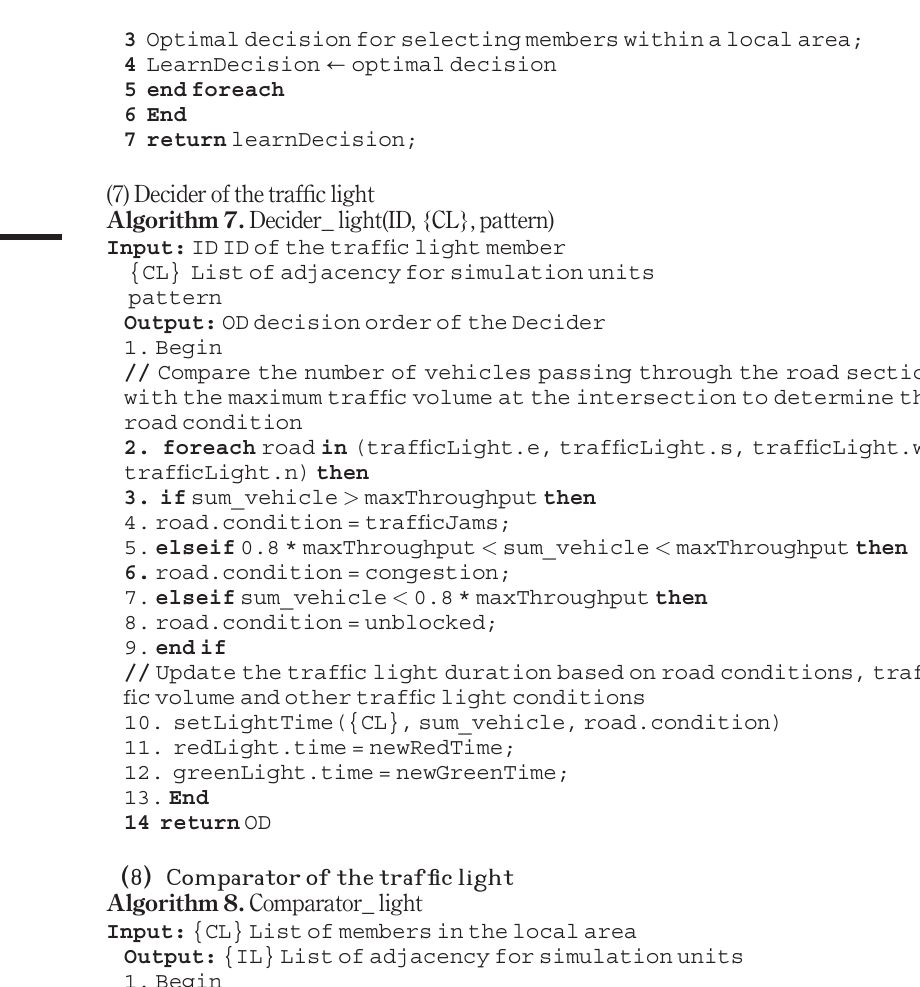
Algorithm 8. Comparator_